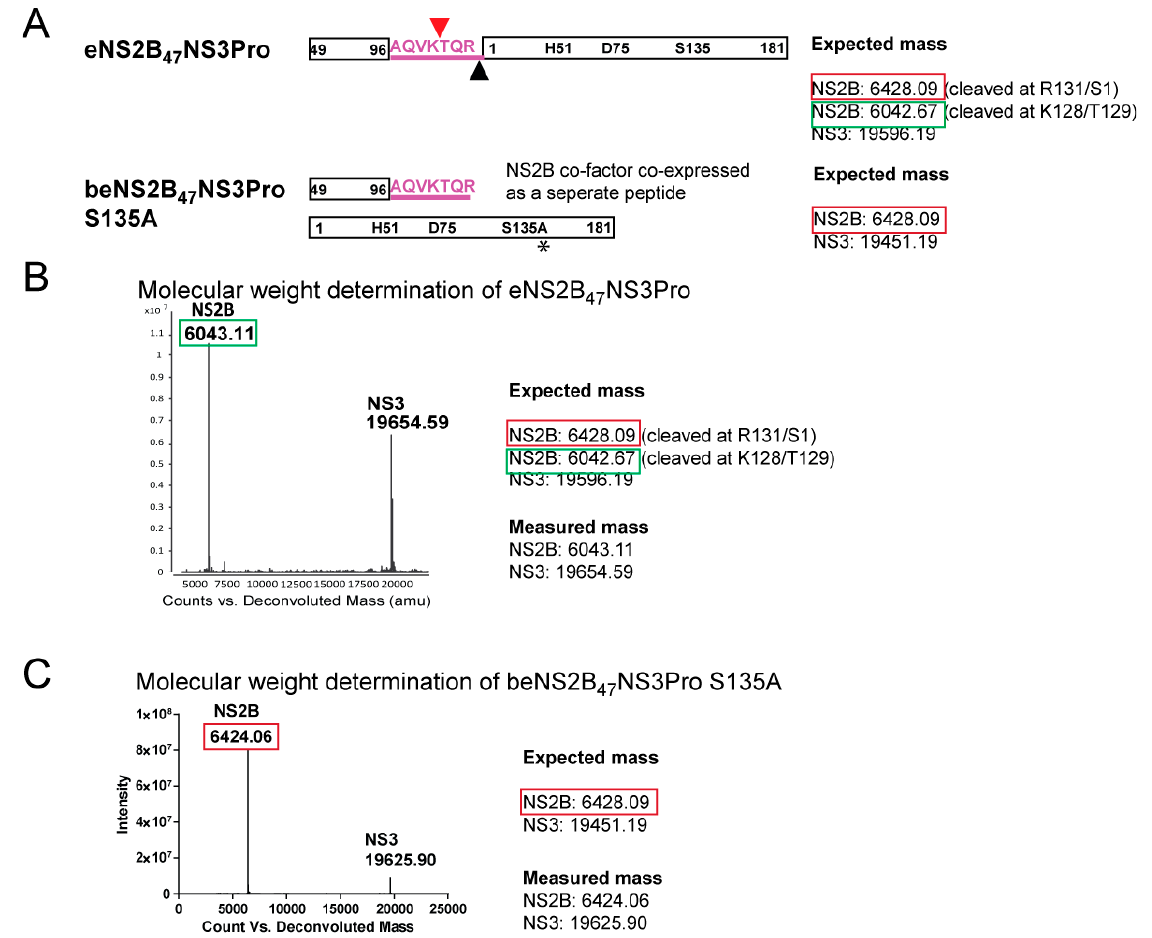
Figure 2. Molecular weight determination of active and inactive DENV4 NS2B 47 NS3 proteases. ( A ) The construct design of eNS2B 47 NS3Pro and beNS2B 47 NS3Pro S135A and the expected molecular weights of the peptides. The mutation, S135A, on beNS2B 47 NS3Pro is indicated in asterisk. ( B ) Deconvoluted mass spectra of eNS2B 47 NS3Pro. The mass of NS2B peptide is lower than the expected mass indicating the truncated form. ( C ) Deconvoluted mass spectra of beNS2B 47 NS3Pro S135A. The measured mass of NS2B peptide reflects the un-truncated form of NS2B in the absence of the protease activity.